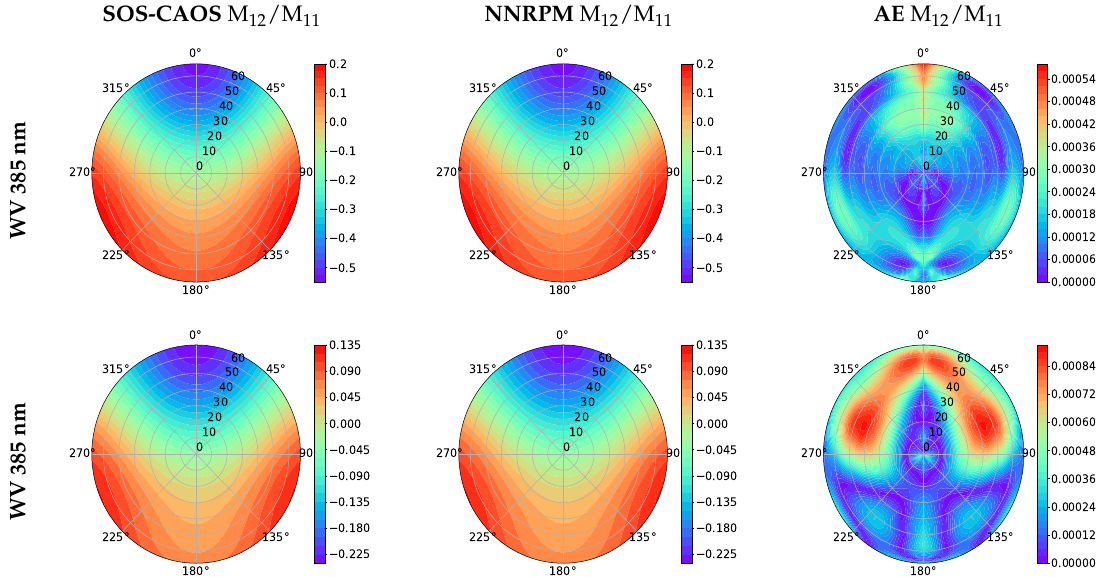
Figure 7. Polar plots of SOS-CAOS, NNRPM and AE for M 12 /M 11 at wavelength 385 nm. Input parameters for Top Row: θ i = 55.91 ◦ , Chla = 20.43 mg/m 3 , a dg ( 440 ) = 7.36 m − 1 , b bp = 0.097 m − 1 , B p = 0.015, S Bp = − 0.157 nm − 1 , S bp = 0.258 nm − 1 , S dg = 0.019 nm − 1 . Input parameters for Bottom Row: θ i = 43.02 ◦ , Chla = 24.77 mg/m 3 , a dg ( 440 ) = 0.004 m − 1 , b bp = 0.099 m − 1 , B p = 0.046, S Bp = − 0.106 nm − 1 , S bp = 0.023 nm − 1 , S dg = 0.014 nm − 1